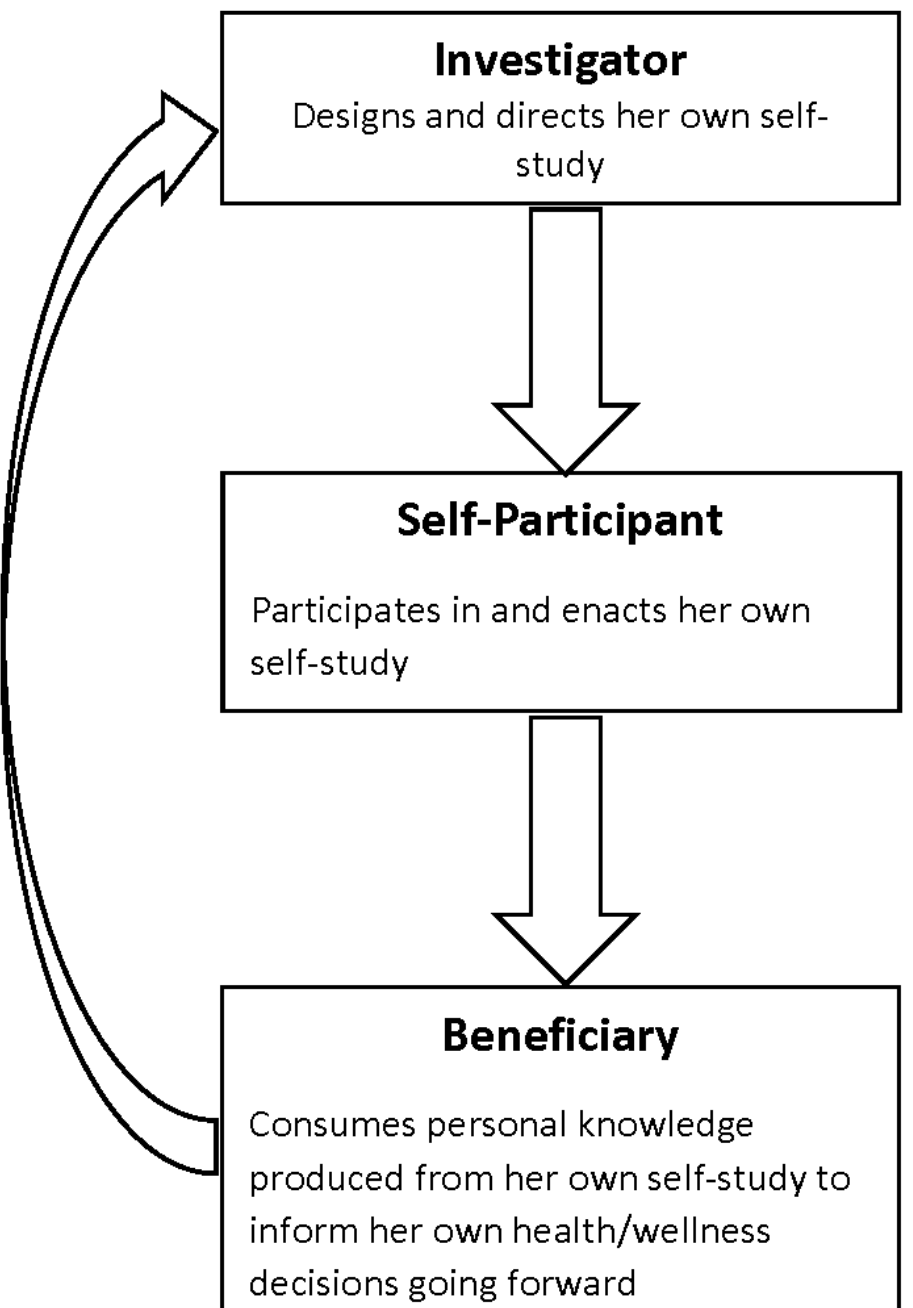
Figure 1. Per-DS investigator serving triple roles